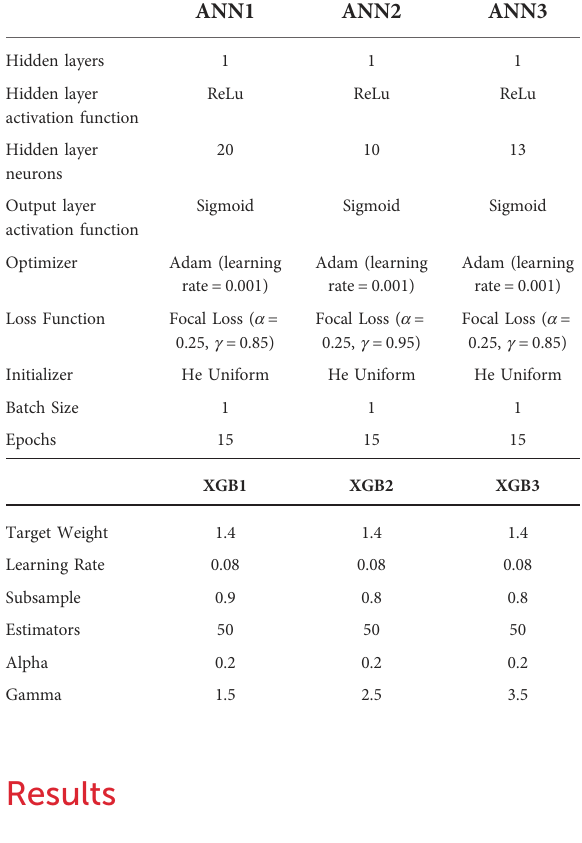
TABLE 4 Tuned hyperparameters. TABLE 5 Logistic regression